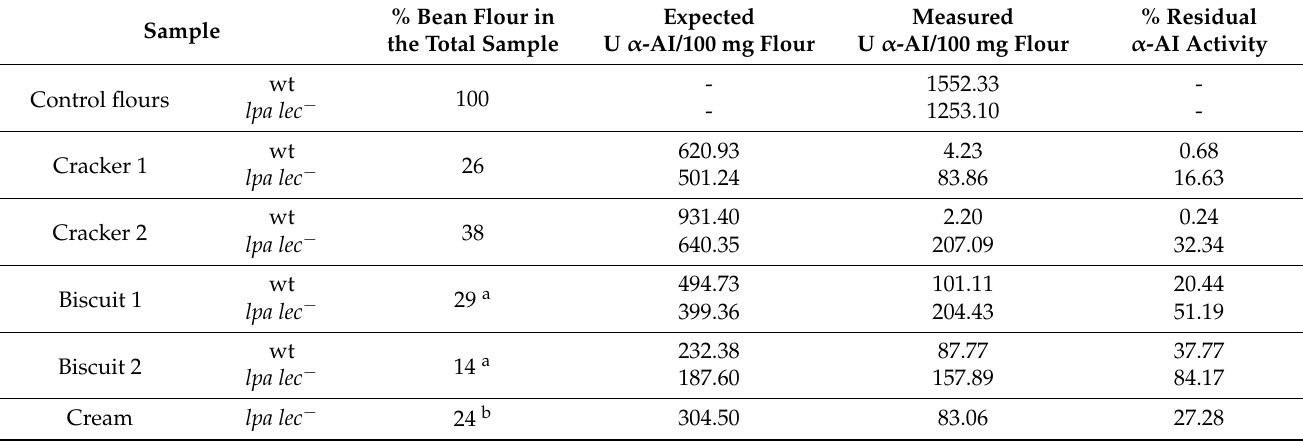
Table 4. α -amylase inhibitor activity (%) in defatted bean-based product extracts. U α -AI, Units of α -amylase inhibitor.